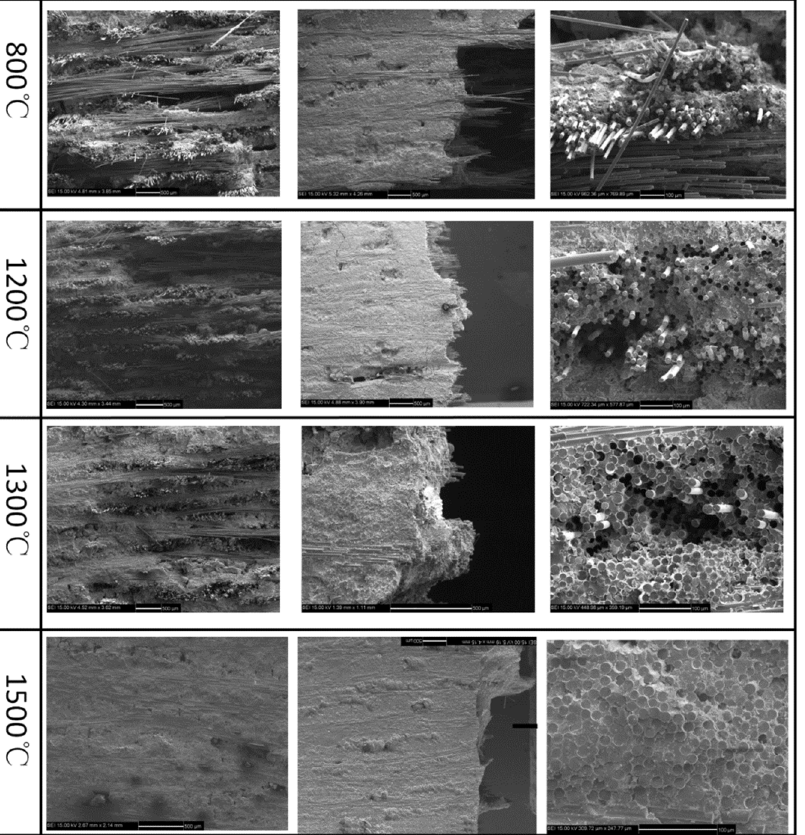
Figure 3. Tensile fracture morphology of SiC–SiC composites at high temperature in air.